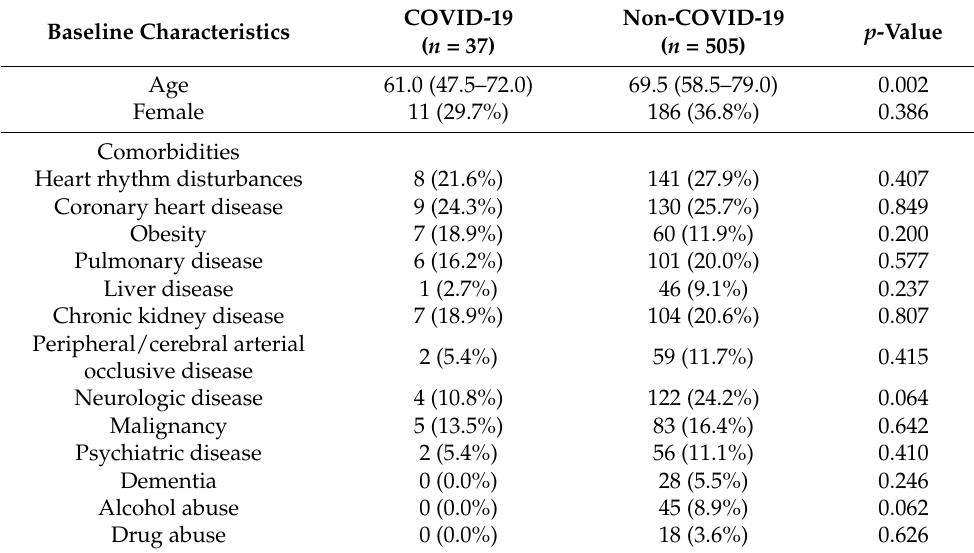
Table 1. Baseline